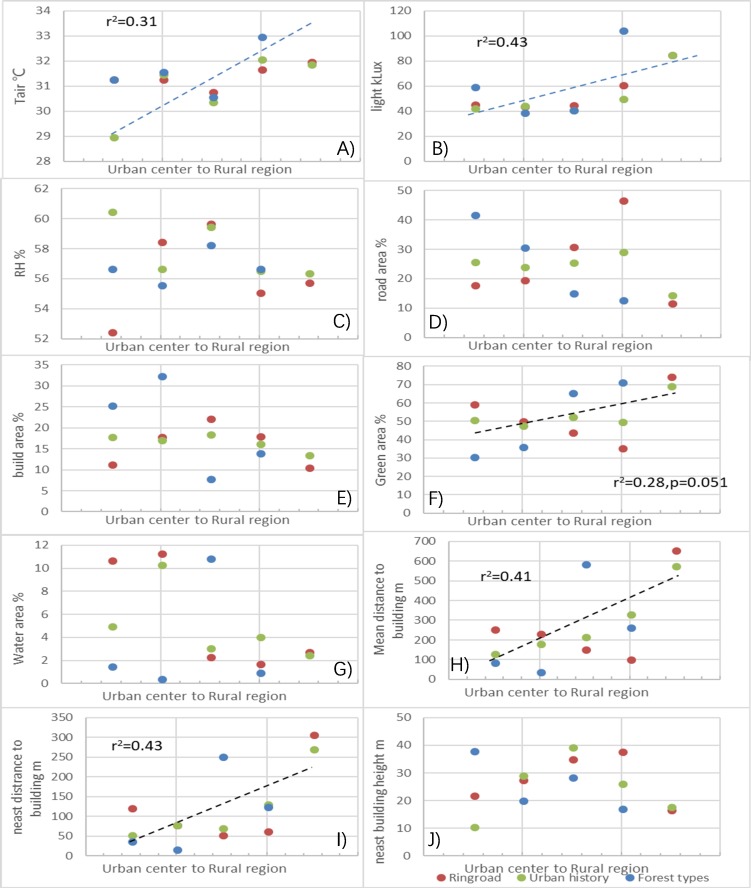
Differences in background conditions where the microclimate regulation by trees was measured in different urban-rural regions.(A) Air temperature; (B) light intensity; (C) air humidity; (D) road area in percentage; (E) building area in percentage; (F) green area in percentage; (G) water area in percentage; (H) mean distance to building from the measured trees; (I) nearest distance to building from the measured trees; (J) nearest building height from the measured trees. Dashed lines in the figures indicate significant changes in the regression analysis (p < 0.05).